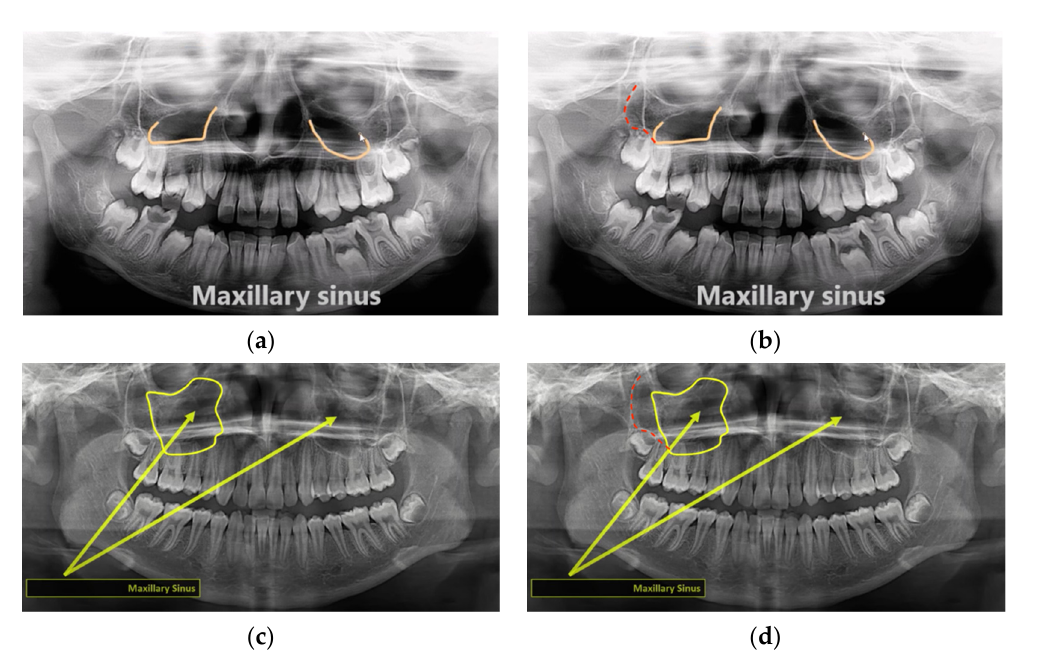
Figure 3. Examples of wrong delineation of the posterior wall of the maxillary sinus and their corrections. ( a ) A video wrongly treated the diagonal line due to the depression of the maxillary sinus anterior wall as the posterior sinus wall and ( b ) the correct tracing of the posterior sinus wall (red dotted line). ( c ) Another example of a video that wrongly identified the zygomatic process of the maxilla as the posterior sinus wall and ( d ) the correct tracing of the posterior sinus wall (red dotted line).